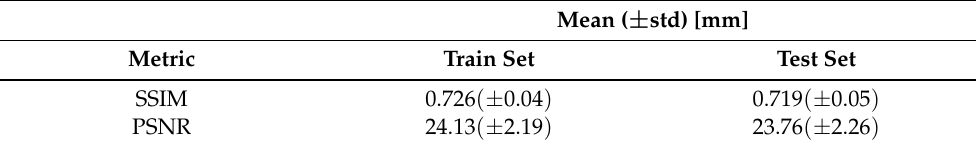
Table 1. Image similarity